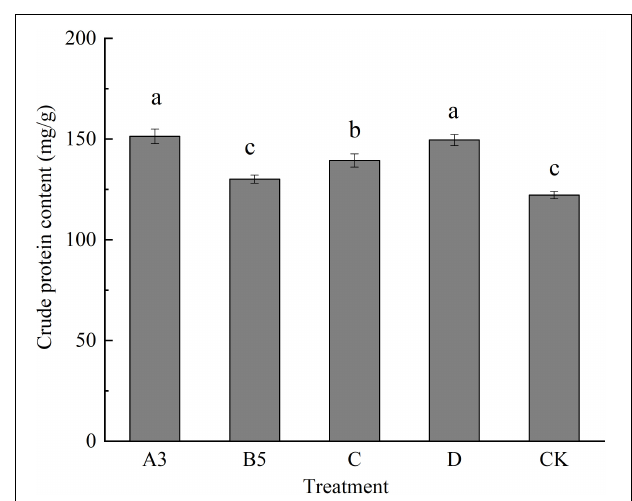
FIGURE 3 | Crude protein content of fruiting bodies of each treatment. Different letters in the figure indicate significant differences ( P < 0.05).